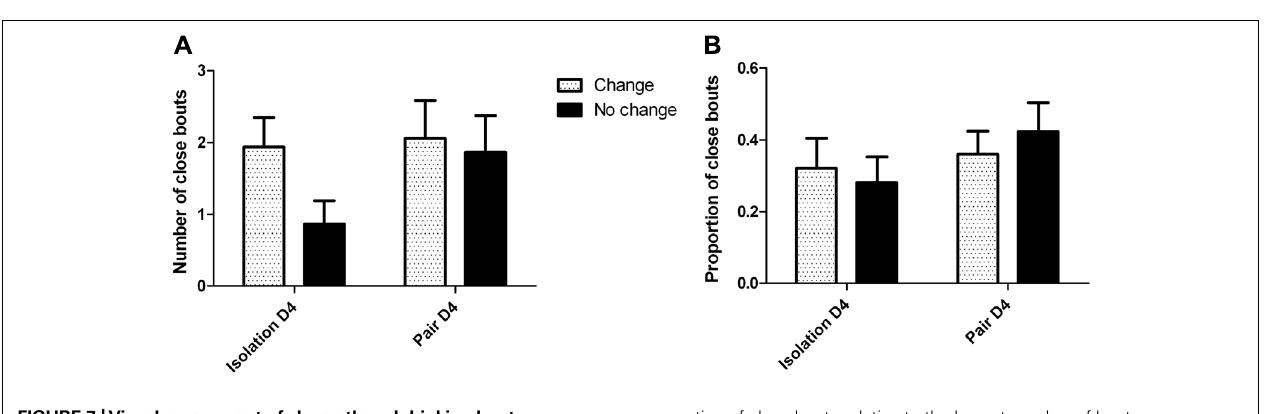
shown in black. Each “step up” in the graph indicates a bout of drinking while each horizontal line indicates a time when no drinking occurred.The red circle indicates bouts that occurred close together in time, within the applied threshold.